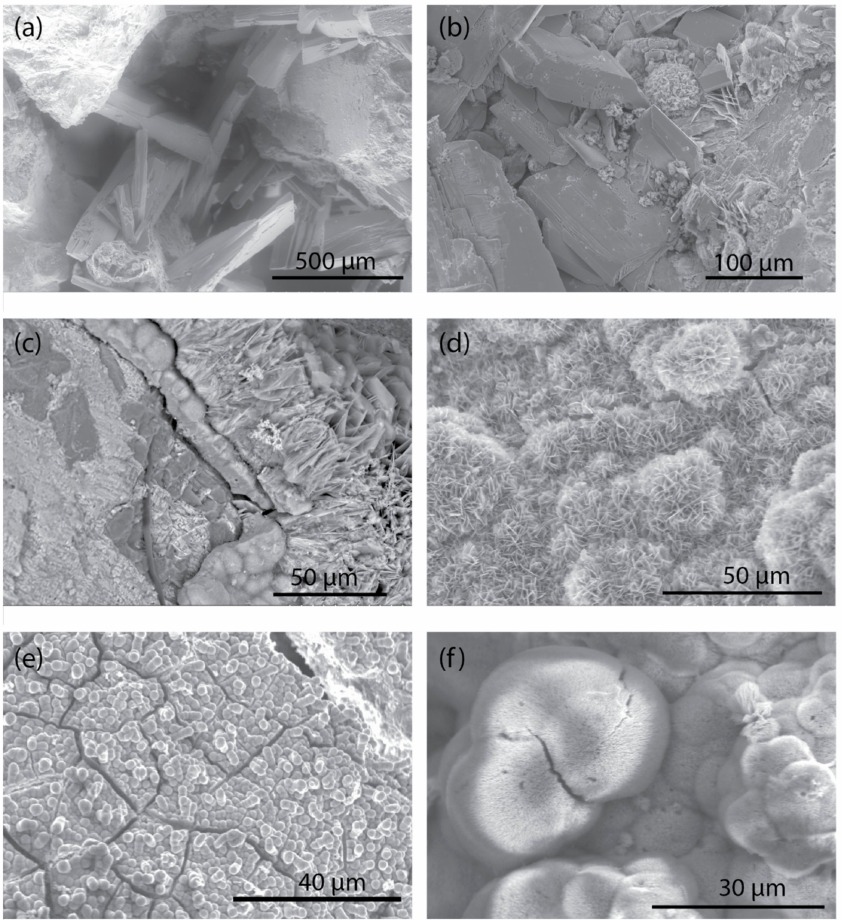
Figure 7. Secondary electron ( a ) and backscattered electron ( b – f ) scanning electron micrographs of reacted slag from phosphate removal column experiments using ferrous slag from the Chicago-Gary area, Illinois and Indiana. Some phases were confirmed by XRD. ( a ) Tabular brushite on reacted ILSS5. ( b ) Tabular Ca phosphate and finer-grained radiating rosette-shaped plates of Fe, Ca and phosphate on reacted ILSS5. ( c ) Layers of Ca phosphate coatings, some with trace amounts of Mn and Mg, on reacted ILSS5. ( d ) Radiating rosette-shaped plates of hydroxylapatite on reacted AMFeC. ( e ) Worm-like morphology of Ca, Mg and phosphate on reacted AMFeC. ( f ) Fibrous nodule morphology of Ca, Zn and phosphate on reacted